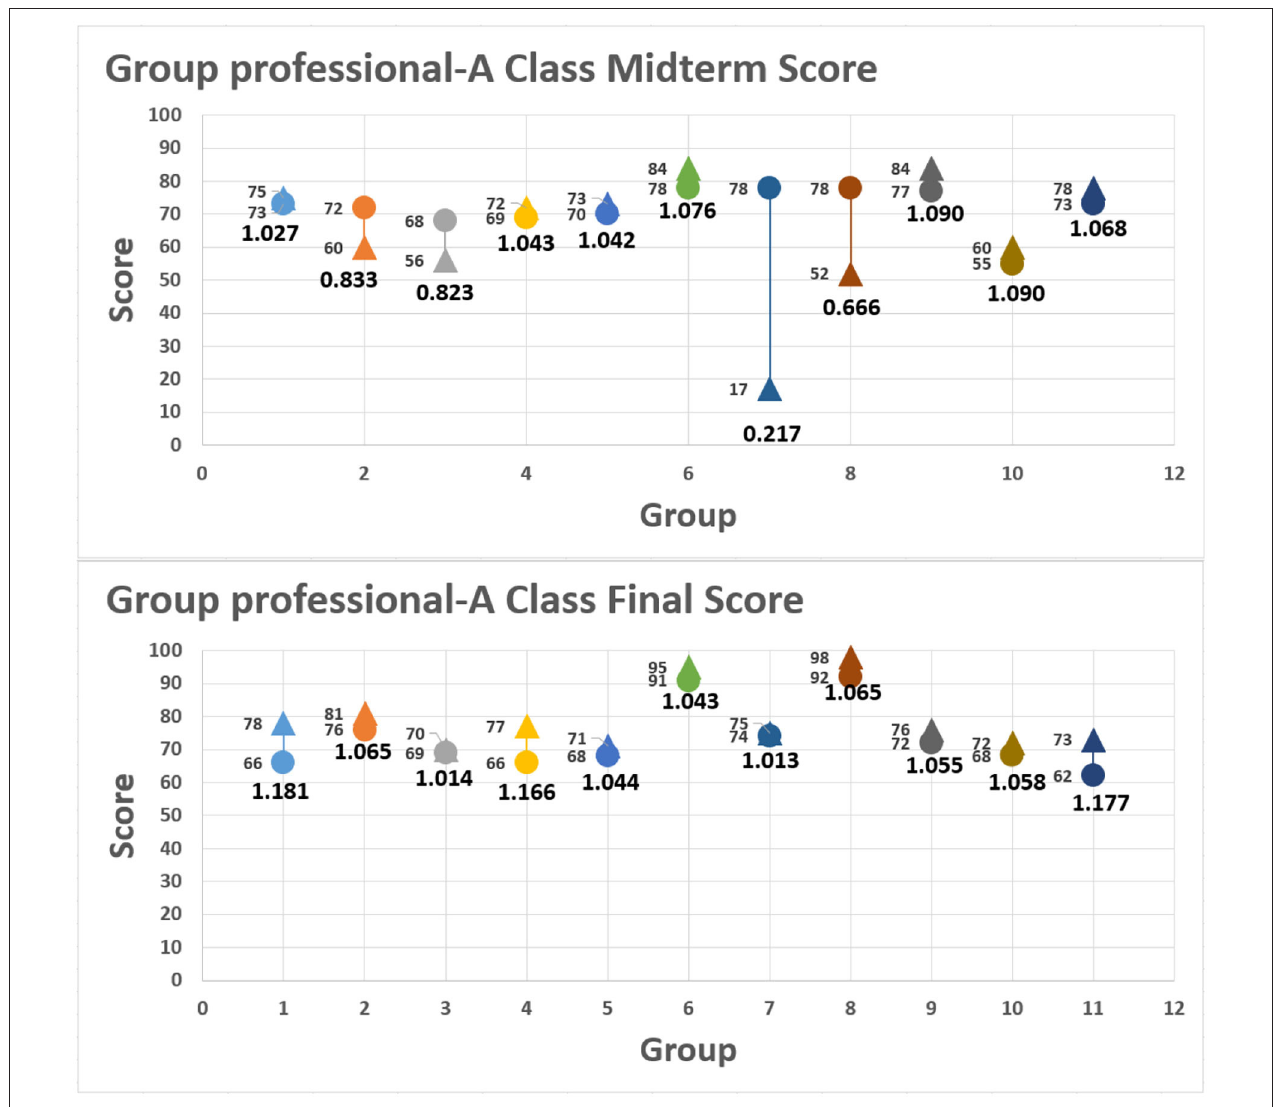
FIGURE 5 | Group professional-level variation: class